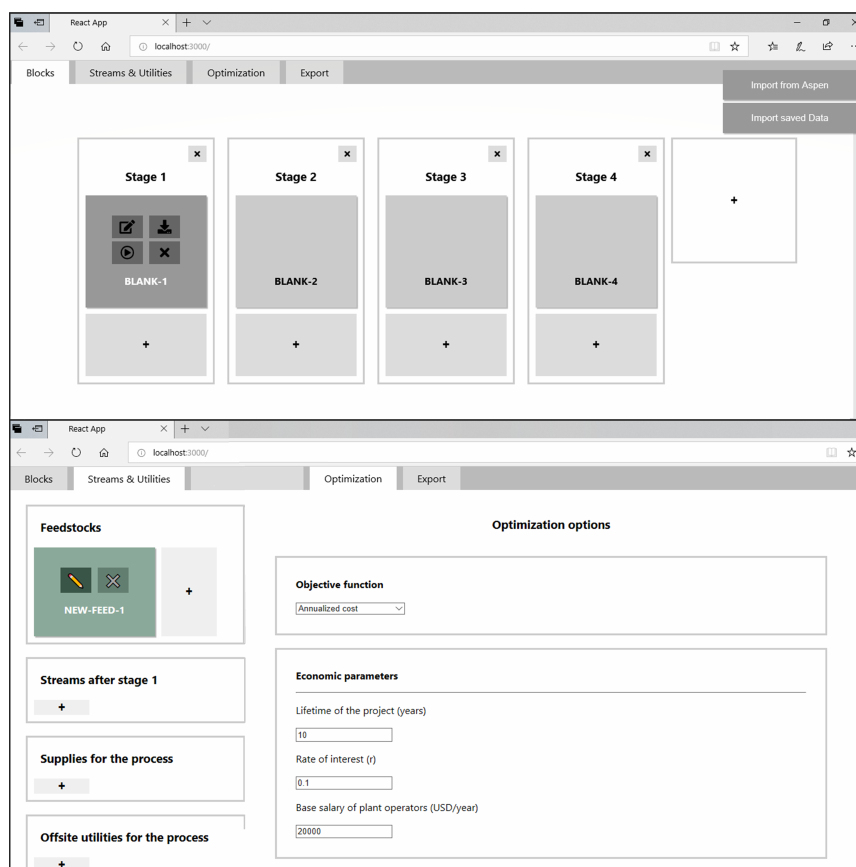
Figure 1. Composite of screenshots of the tool. Top: The technology blocks tab. Users enter as many technology stages and as many blocks for each stage as desired. Upon pointing with the mouse, two options for data loading (manual and from an Aspen Plus .bkp file) and the option for programmatically running Aspen Plus are displayed. Bottom Left: Streams and Utilities tab. Users enter here the name and prices for the different compounds (see text for definition of compounds in this context). Bottom Right: Optimization Tab: Users select objective function and parameters. Currently options for maximization of the Net Present Value (NPV) and minimization of Annualized Cost have been